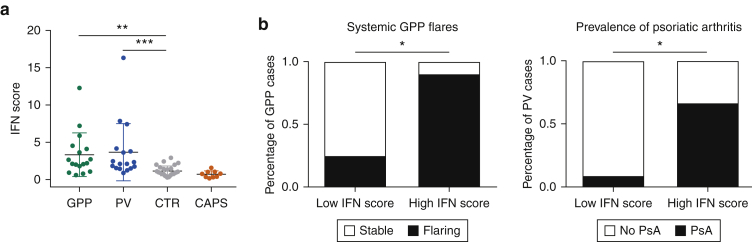
Validation of the IFN-I signature in extended datasets. (a) Elevated IFN score in the neutrophils of patients with GPP and PV compared with healthy individuals. CAPS cases were analyzed as negative controls. The data are presented as mean ± SD; **P < 0.01 and ***P < 0.001 (1-way analysis of variance followed by Dunnett’s posttest). (b) Left: systemic flares are more prevalent in patients with GPP with high IFN scores (n = 8) compared with those with low IFN scores (n = 9). Right: PsA) is more prevalent in patients with PV with high IFN scores (n = 6) compared with those with low IFN scores (n = 11). In both groups, the cut-off between high and low scores was defined as the median +2SD of the values observed in healthy controls. *P < 0.05 (Fisher exact test). CAPS, cryopyrin associated periodic syndrome; GPP, generalized pustular psoriasis; PsA, psoriatic arthritis; PV, psoriasis vulgaris; SD, standard deviation.